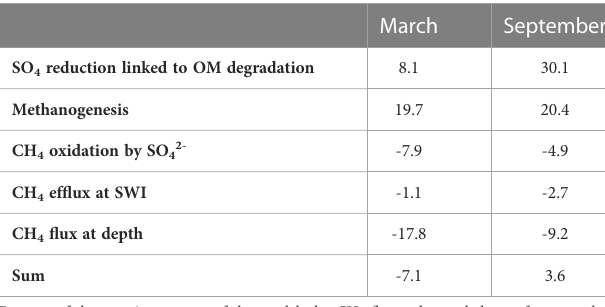
TABLE 2 Depth-integrated rates of SO 4 reduction coupled to organic matter degradation and mass balance for CH 4 for the upper 100 cm of the sediment for March and September 2020 as calculated with the